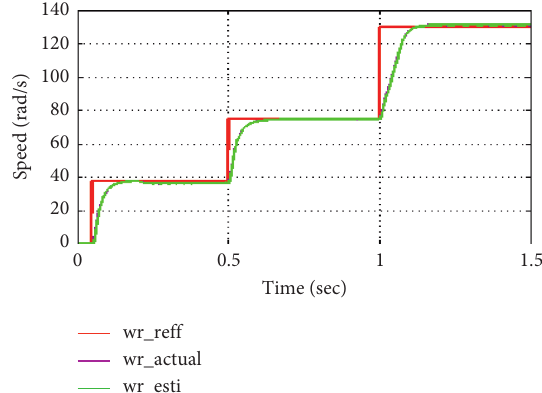
Figure 15: 50% decrease of R rotor